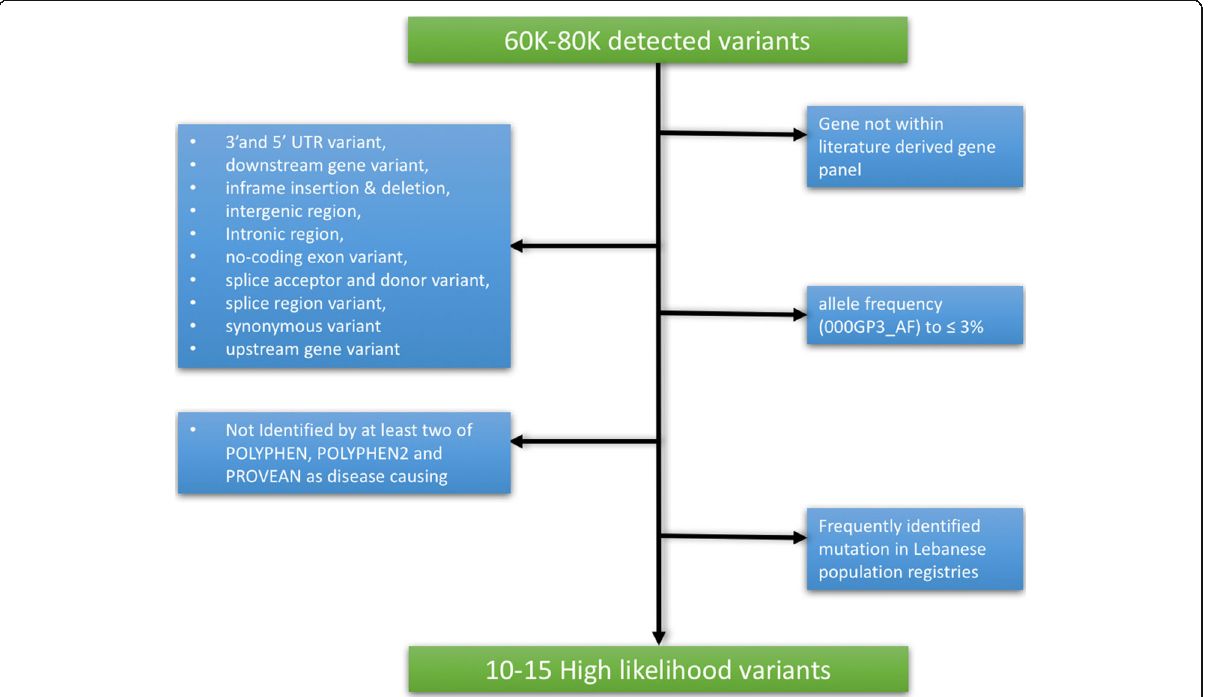
Fig. 1 Stepwise strategy for filtering variants to reach 10 – 15 highly likely disease-causing variants per patient screened. UTR = Untranslated Region; AF = allele